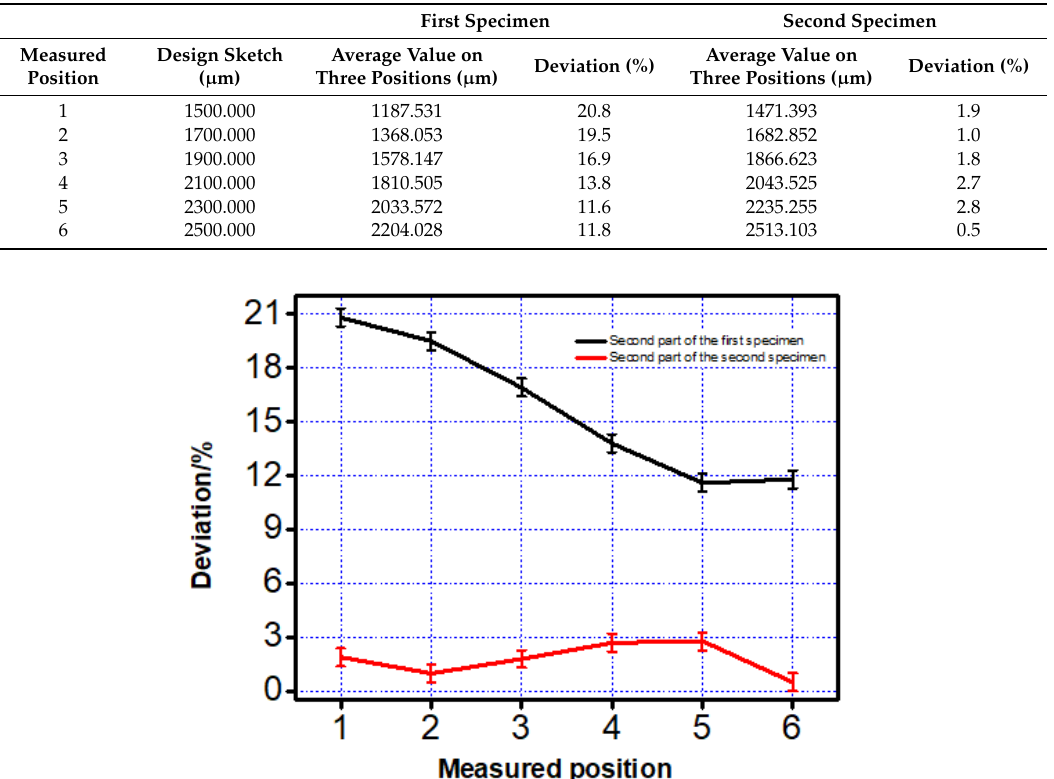
Figure 6. Deviation between the measured and designed data of the two specimens on the second part.